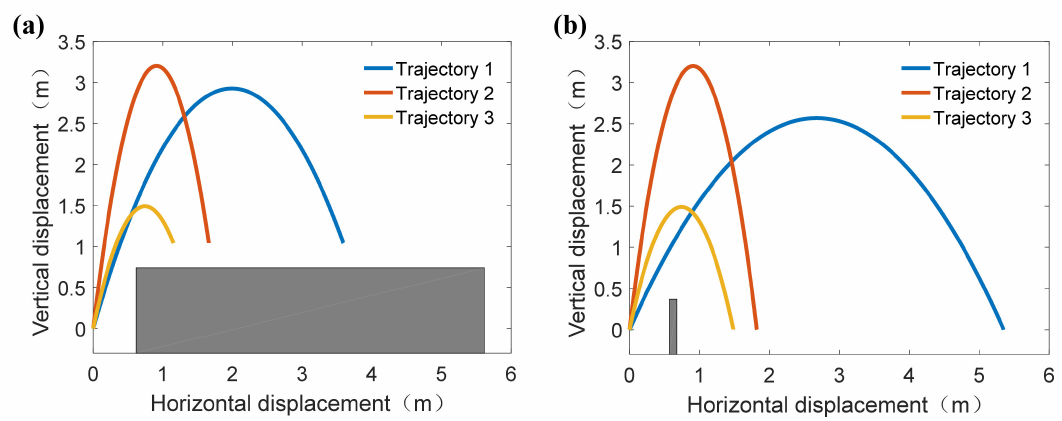
Figure 7. The optimal jumping trajectory under different weight coefficient combinations. ( a ) The optimal centroid jumping trajectories of jumping robot while jumping onto platform. ( b ) The optimal jumping centroid trajectories of jumping robot while jumping over the platform.